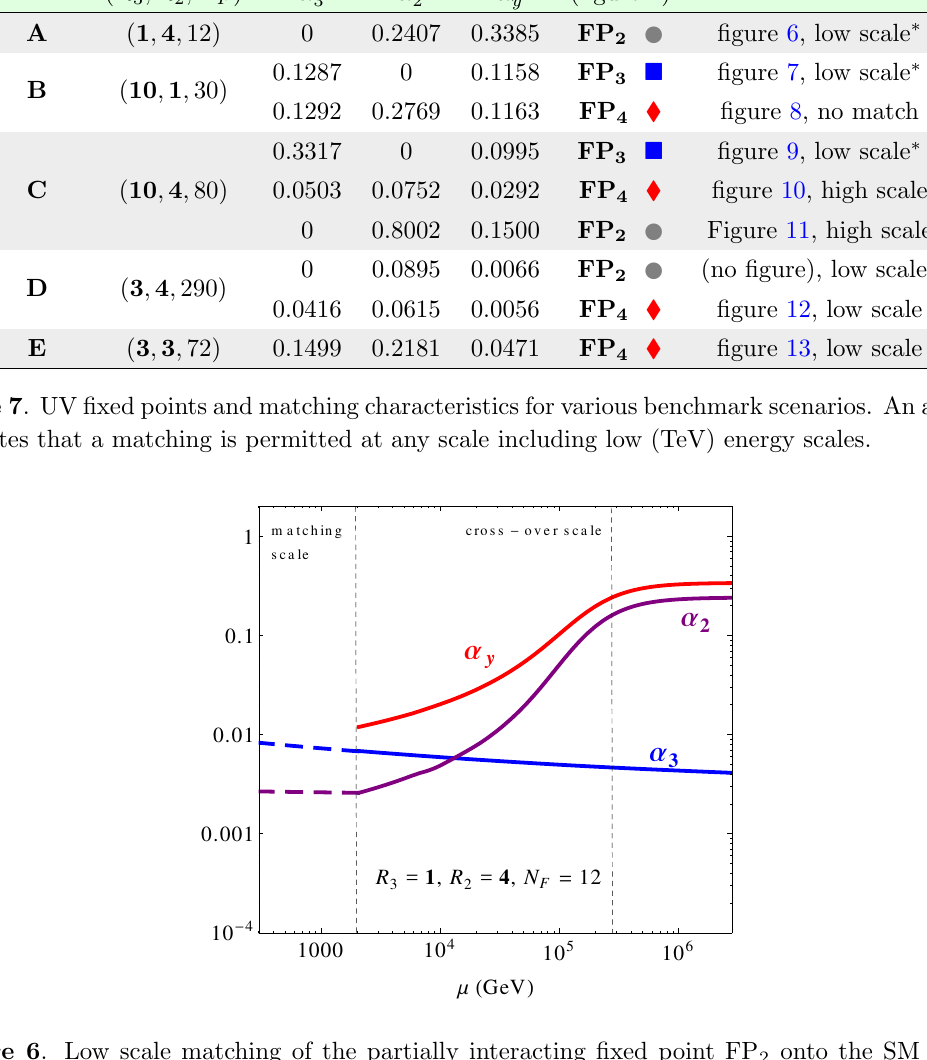
Figure 6 . Low scale matching of the partially interacting (cid:12)xed point FP 2 onto the SM for the benchmark scenario A with ( R 3 ; R 2 ; N F ) = ( 1 ; 4 ; 12) and M = 2 TeV. BSM (SM) running is shown by full (dashed) lines. Around the cross-over scale the BSM running of (cid:11) 2 and (cid:11) y slows down from power-law to logarithmic. Notice that the running of the strong coupling is not modi(cid:12)ed by BSM